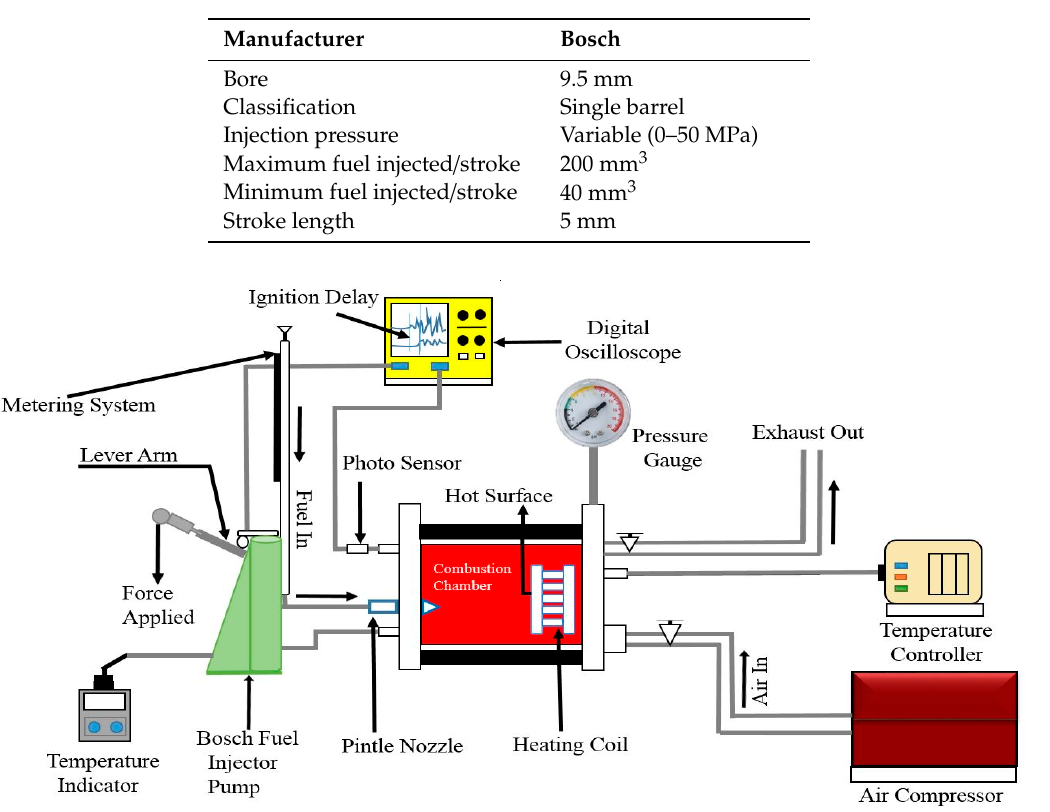
Figure 1. Scheme of the experimental setup.